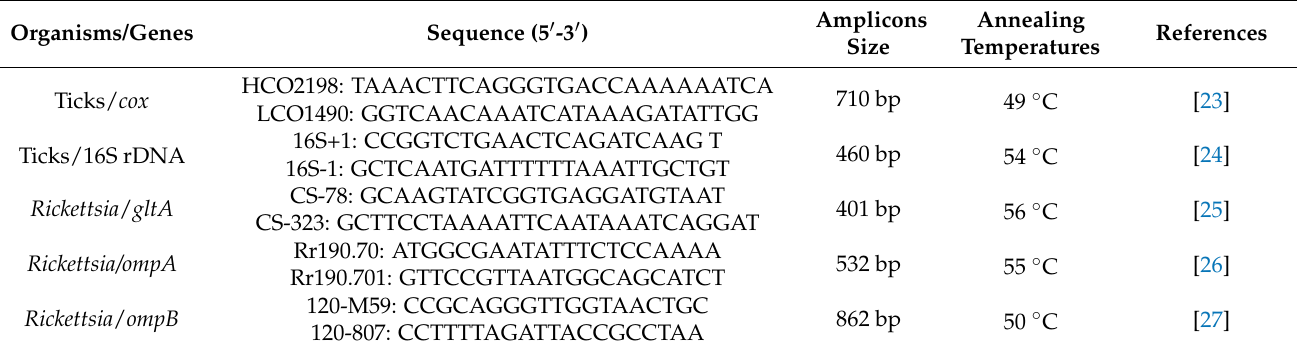
Table 1. Primers and PCR conditions used in the current